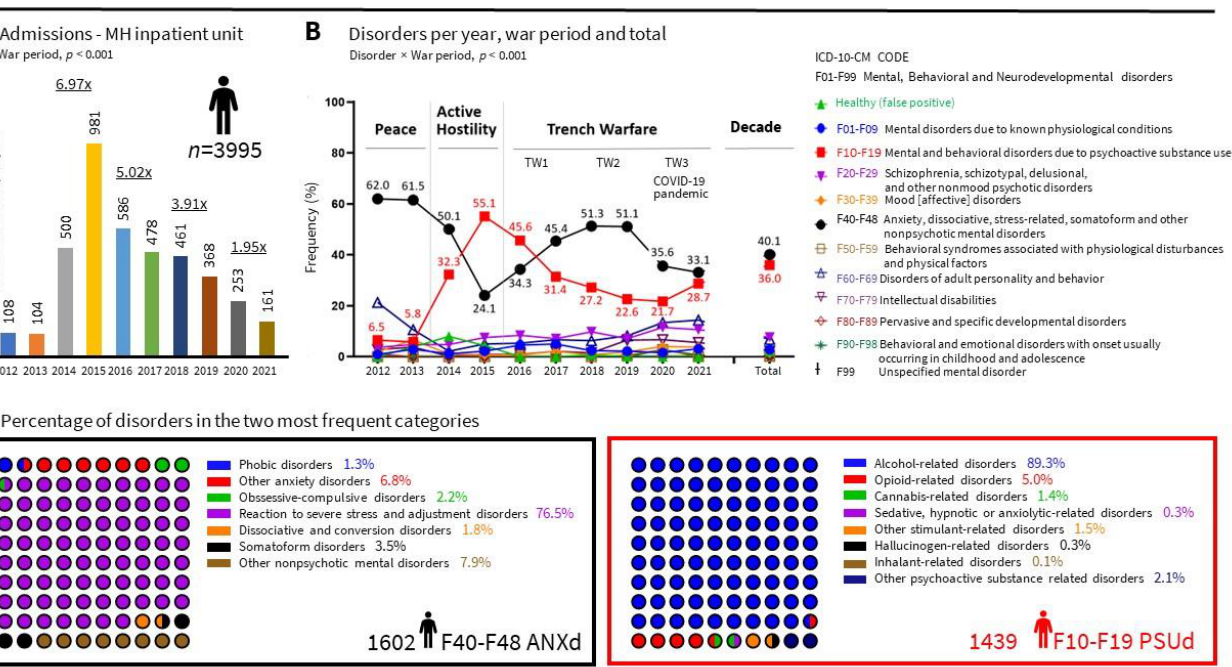
Figure 1. Mental health distribution in a Ukrainian Military Hospital during the last decade. ( A ) Temporal distribution of admissions in a mental health (MH) inpatient unit. ( B ) Frequency (%) of disorders per year, war period, and decade. ( C ) Frequencies of disorders in the two most frequent categories. ANXd: Anxiety, dissociative, stress-related, somatoform and other nonpsychotic mental disorders; PSUd; Mental and behavioral disorders due to psychoactive substance use. Statistics (see depicted in the insets): Frequencies (%), Chi-square.